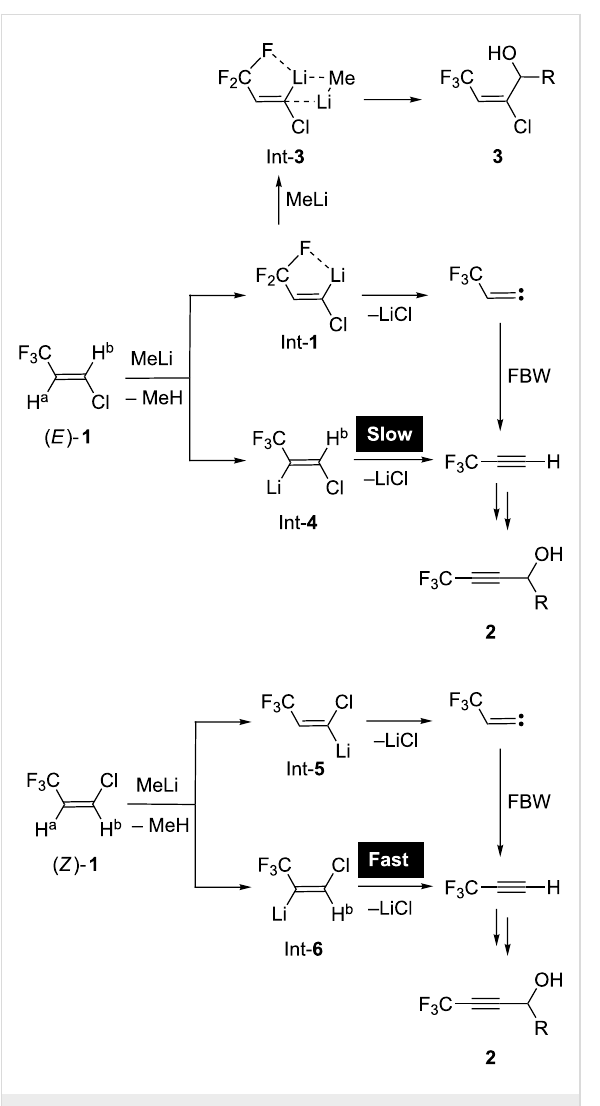
Scheme 5: Alternative reaction mechanism between 1 and